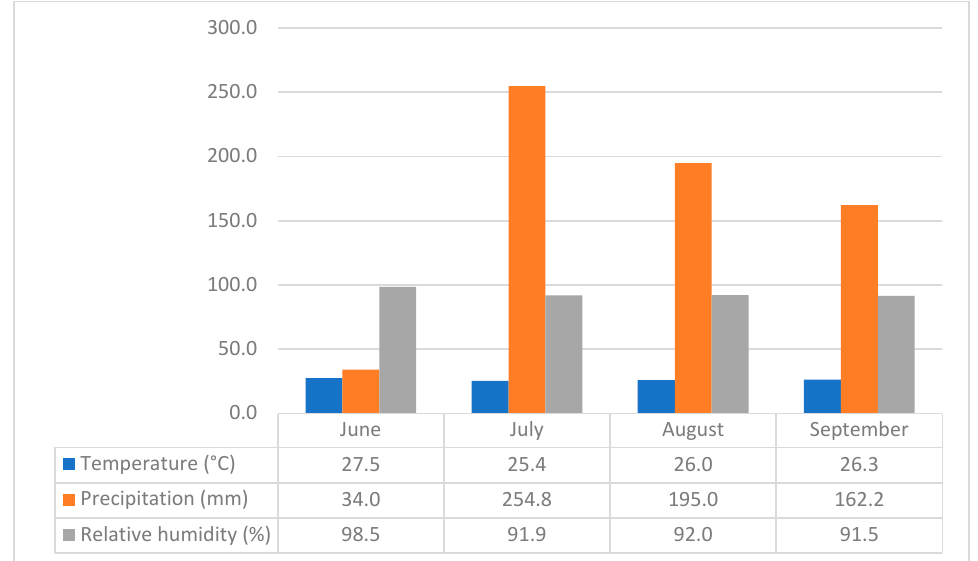
Figure 2. Agroclimatic variables of the study site reported by the portable weather station during four months of study.